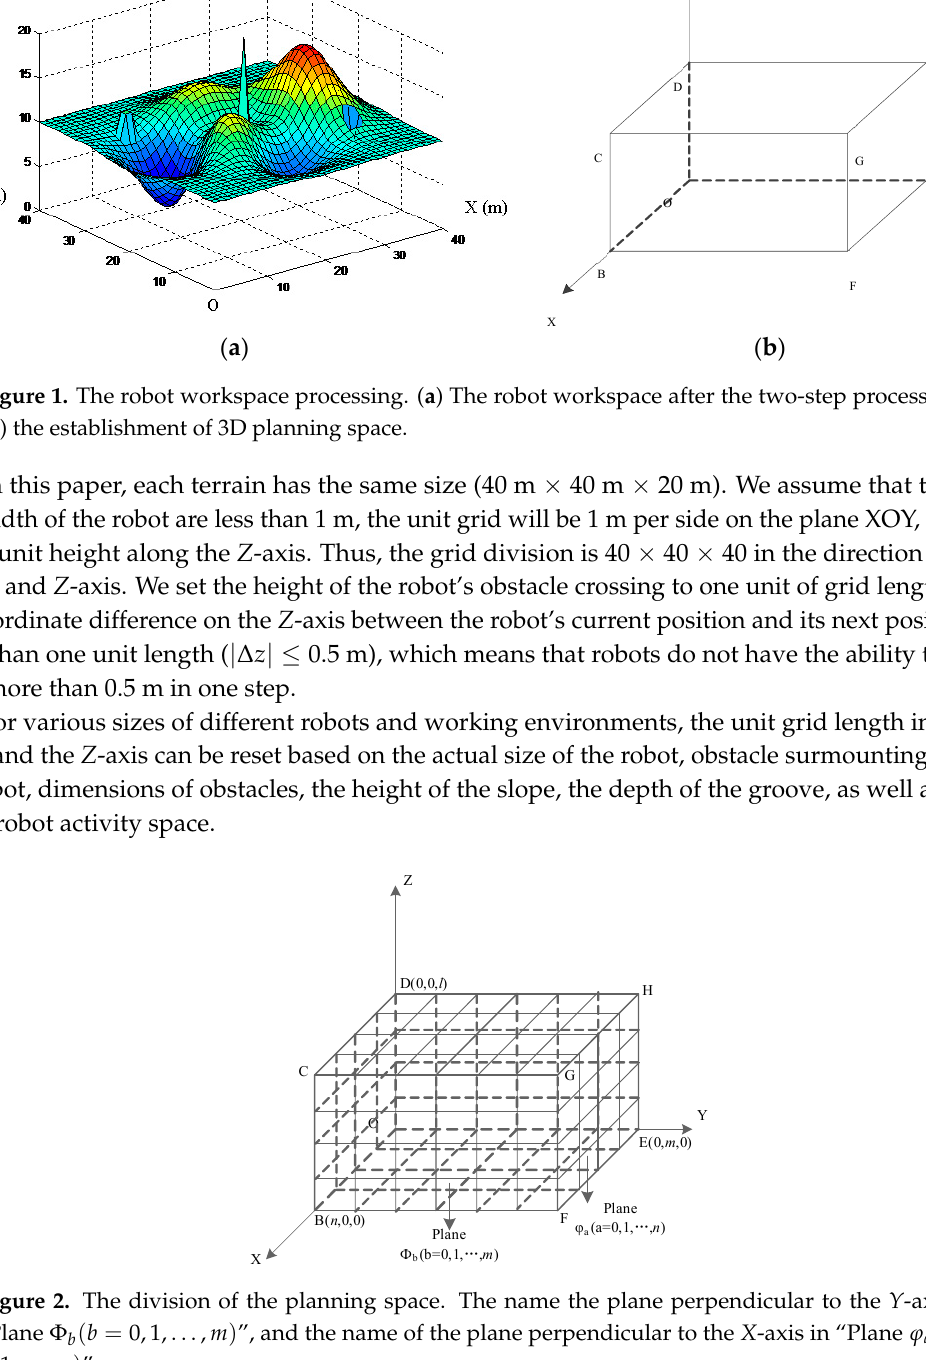
Figure 1. The robot workspace processing. ( a ) The robot workspace after the two-step process; and ( b ) the establishment of 3D planning space.